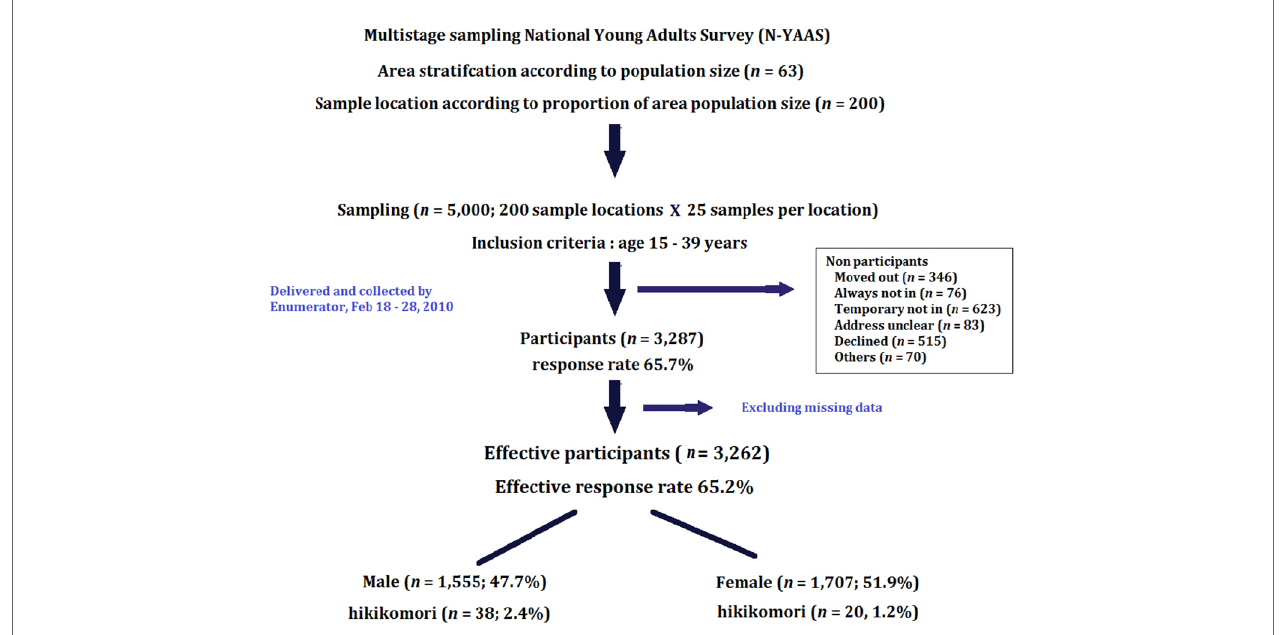
FIGURE 1 | Flow chart of the sampling